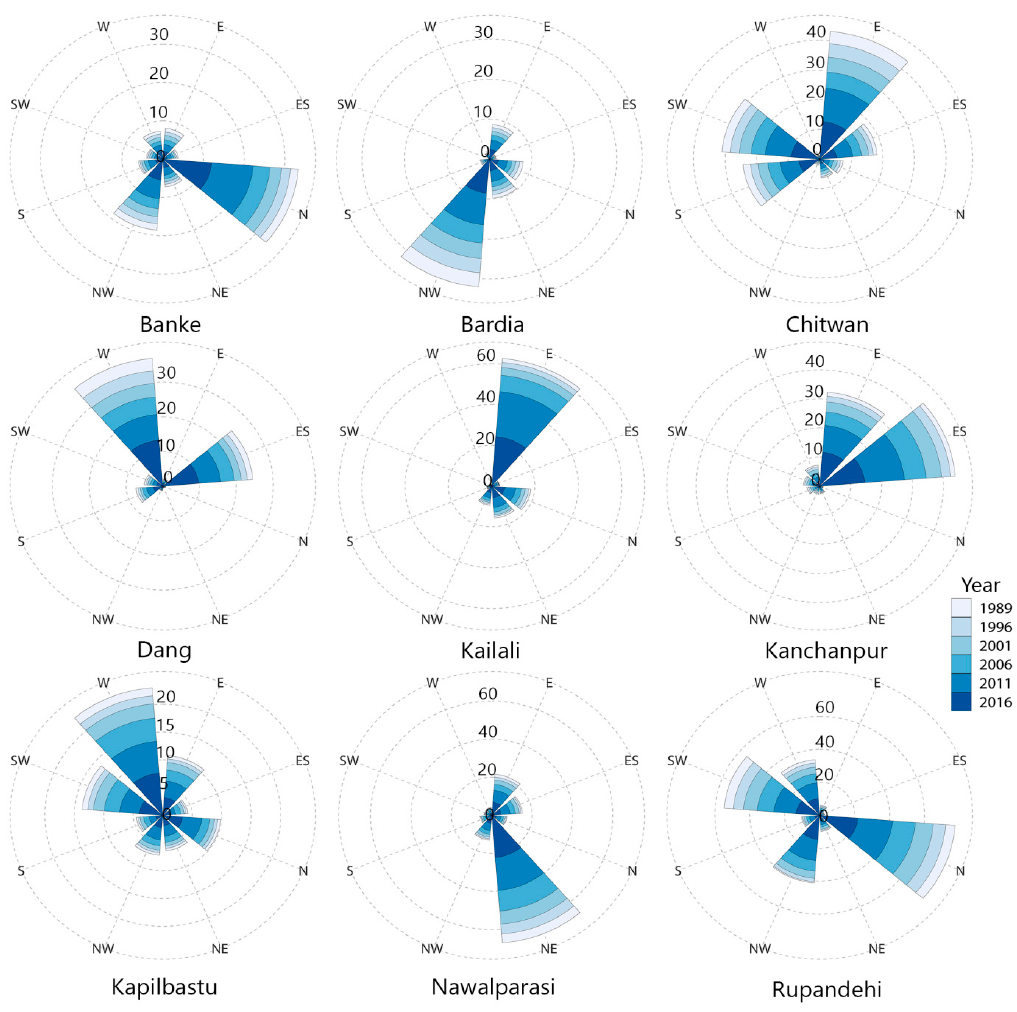
Figure 5. Urban-expansion orientation graphs, by district, for six historical periods between 1989 and 2016.